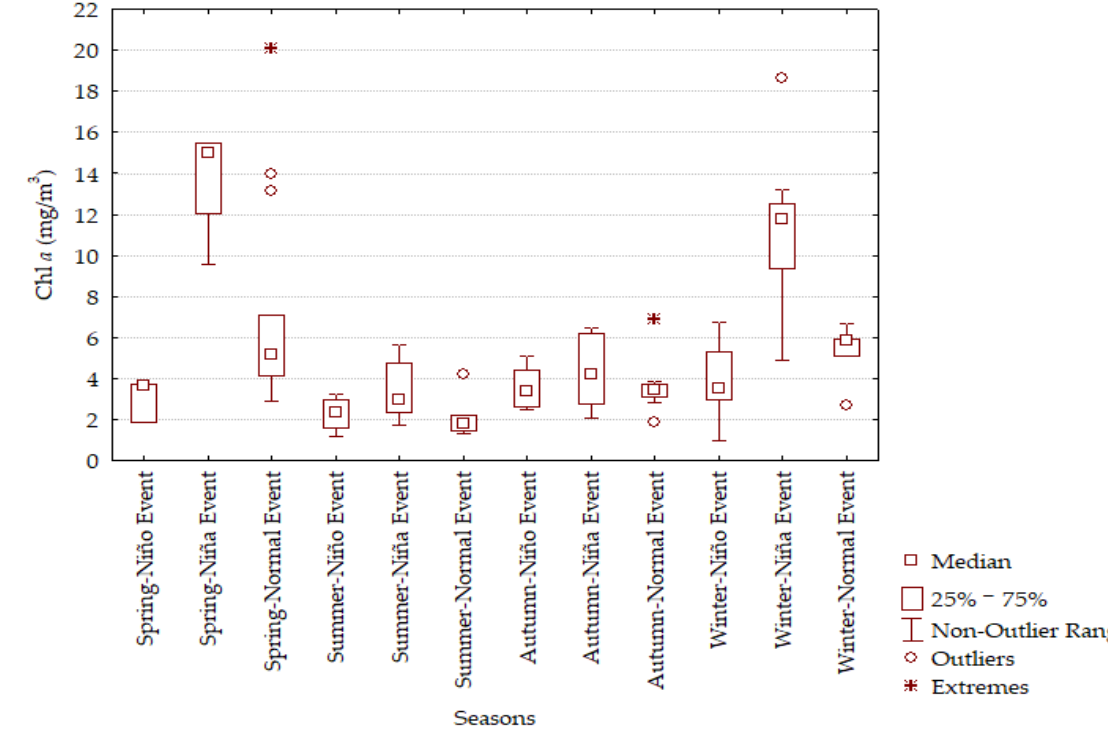
Figure 10. Box-whisker plots for monthly Chlorophyll a (Chl a ) concentrations in different seasons during the interannual events for Piaxtla-Urías region of the Northwest of Mexico.